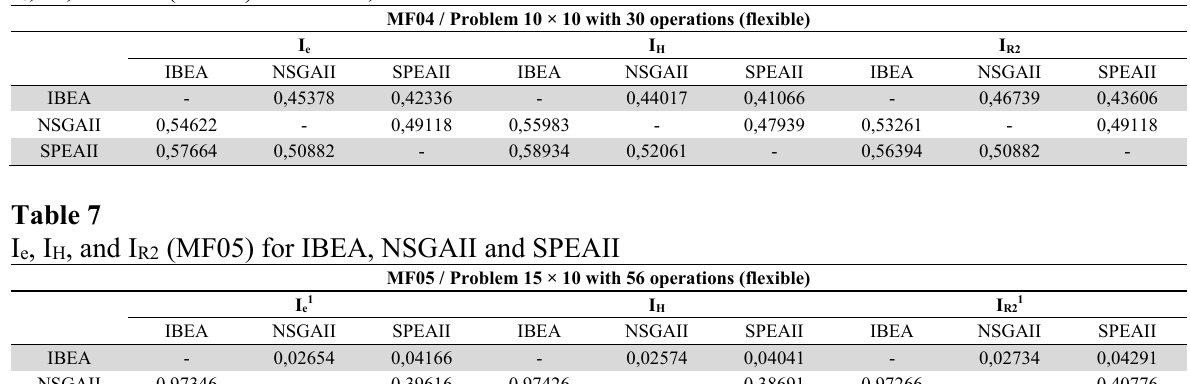
f , * f to the actual 1,i 2,i